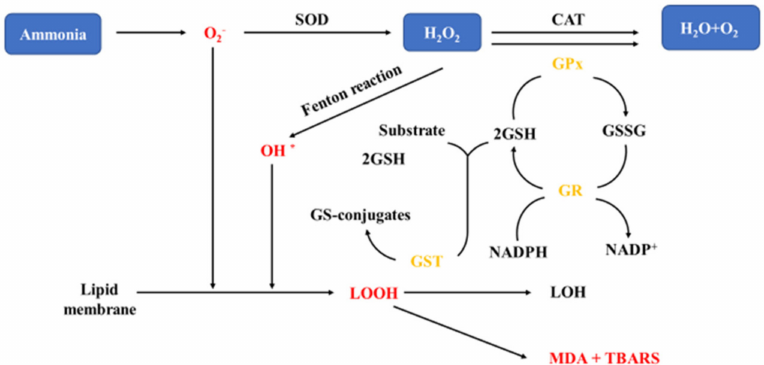
Figure 2. Oxidative stress mechanisms in fish exposed to ammonia [81]. H 2 O 2 : hydrogen perox- ide; SOD: superoxide dismutase; CAT: catalase; GSH: glutathione; GST: Glutathione